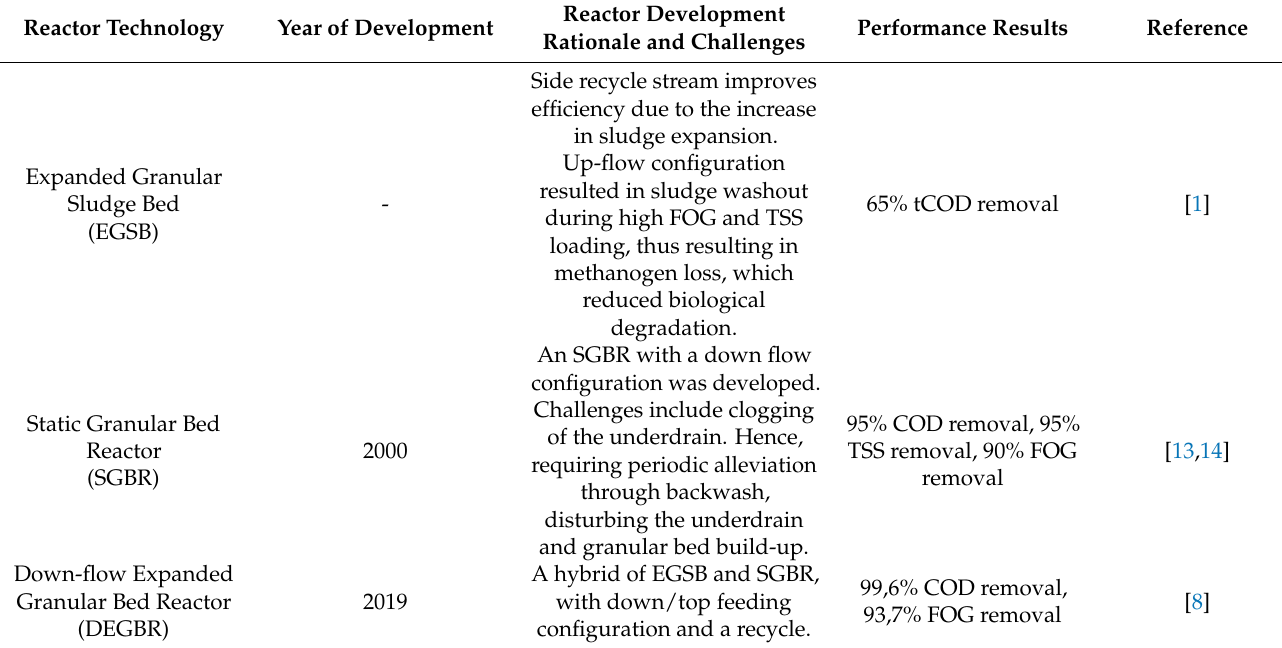
Table 1. Achieved effluent quality from past studies for PSW treatment.